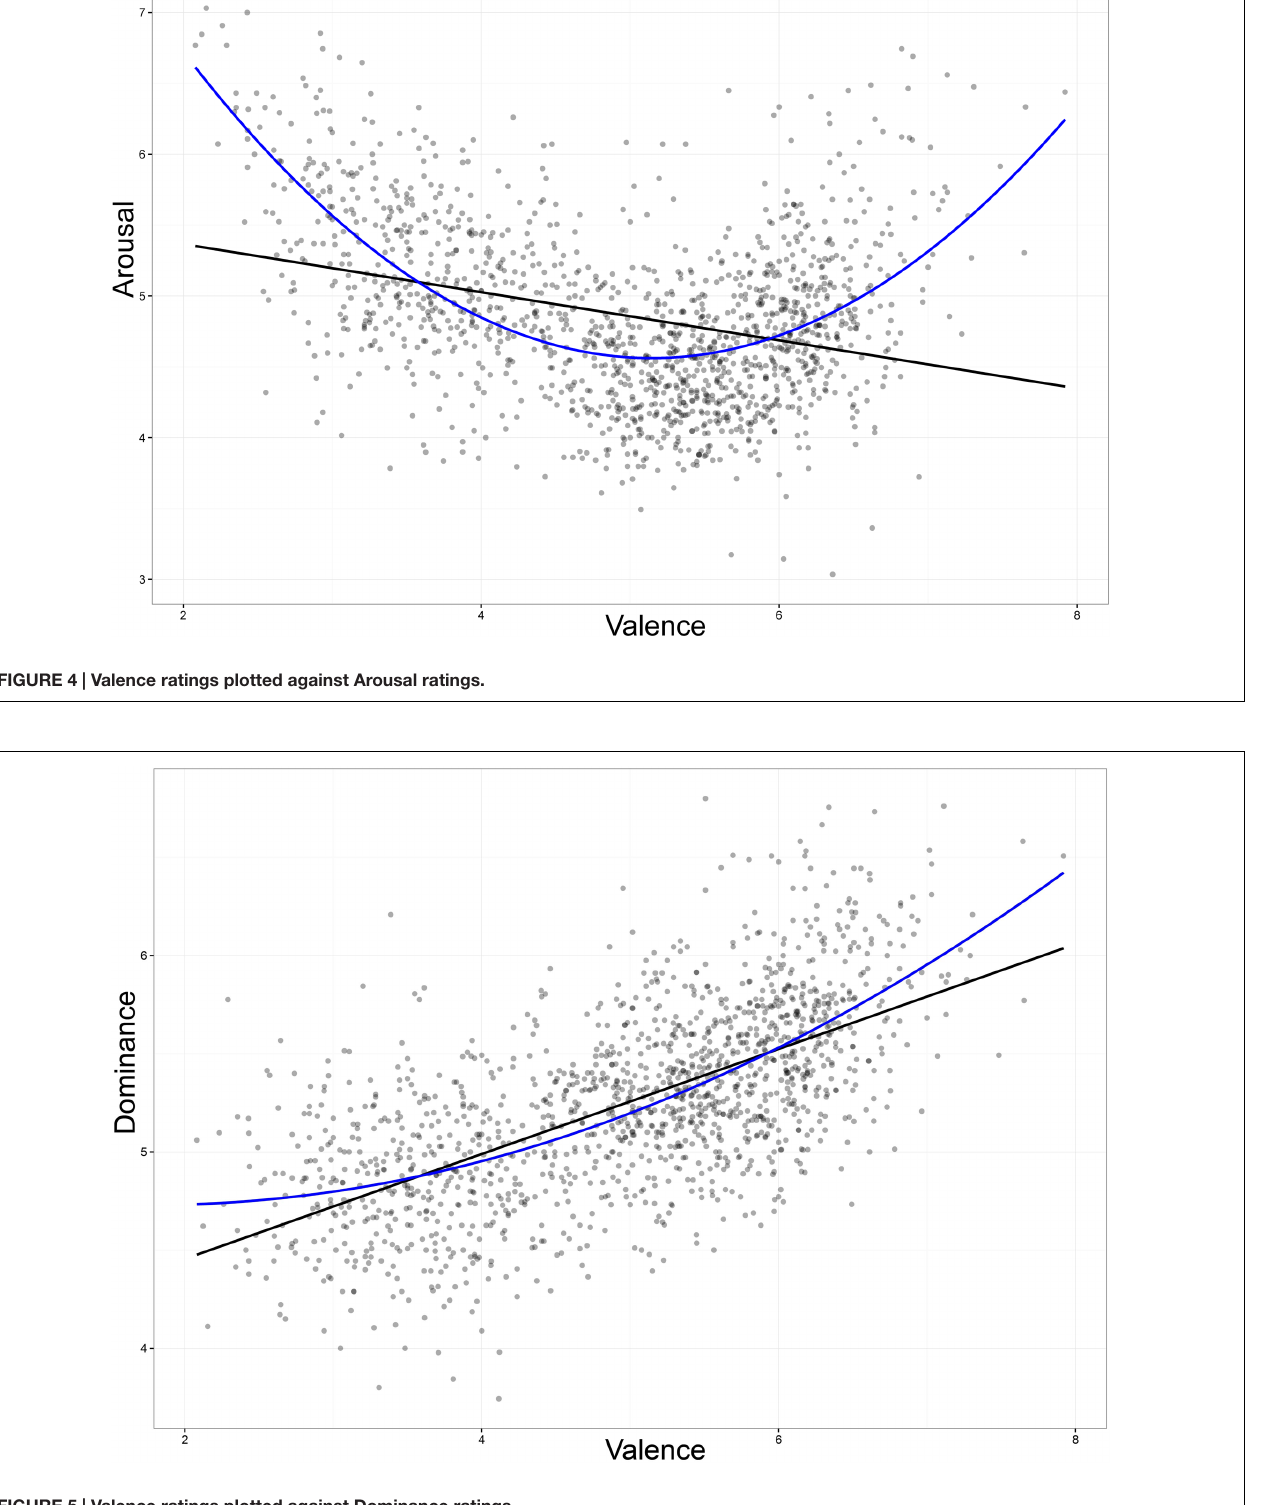
FIGURE 5 | Valence ratings plotted against Dominance